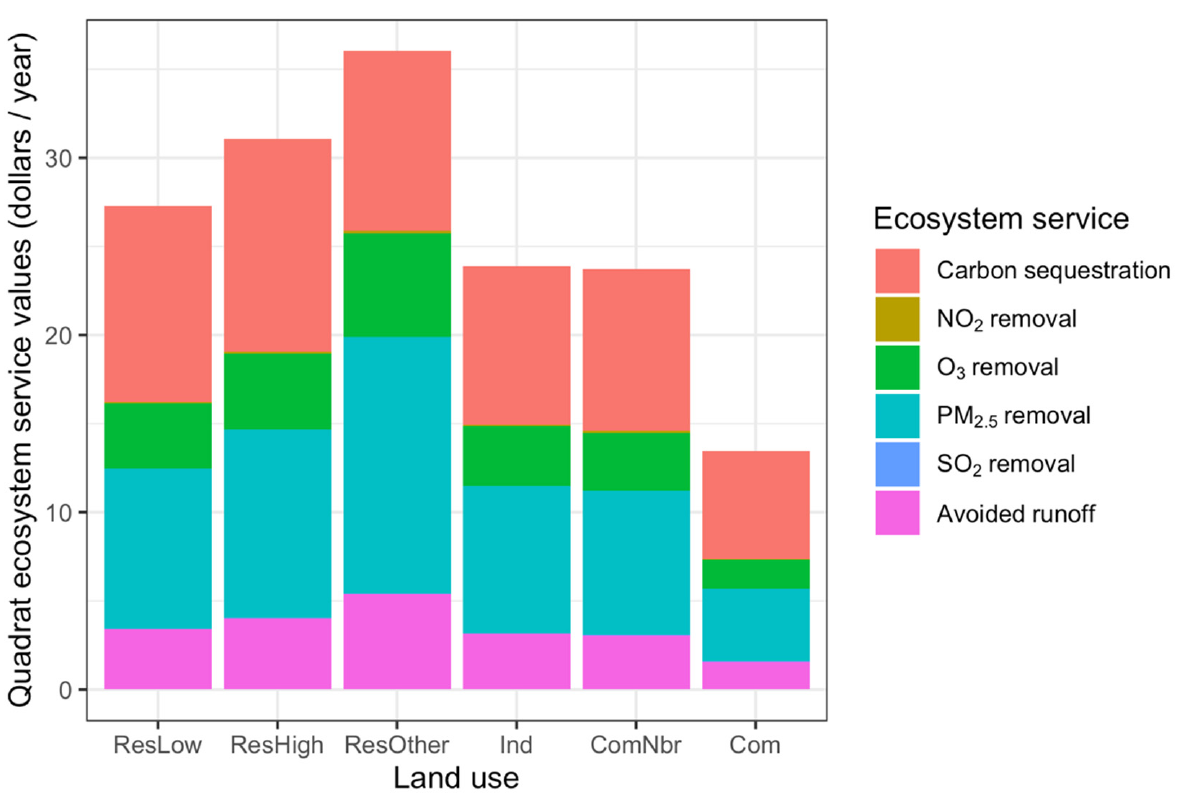
Table 2. Valuation of ecosystem services and compensatory value (unit: US dollars). Item Sum Quadrat Average Quadrat Median Annual ecosystem services 4285 28 10 Carbon storage 14,339 95 16 Compensatory value 518,712 3435 1128 Regarding the composition of quadrat annual ecosystem service values (Figure 4),